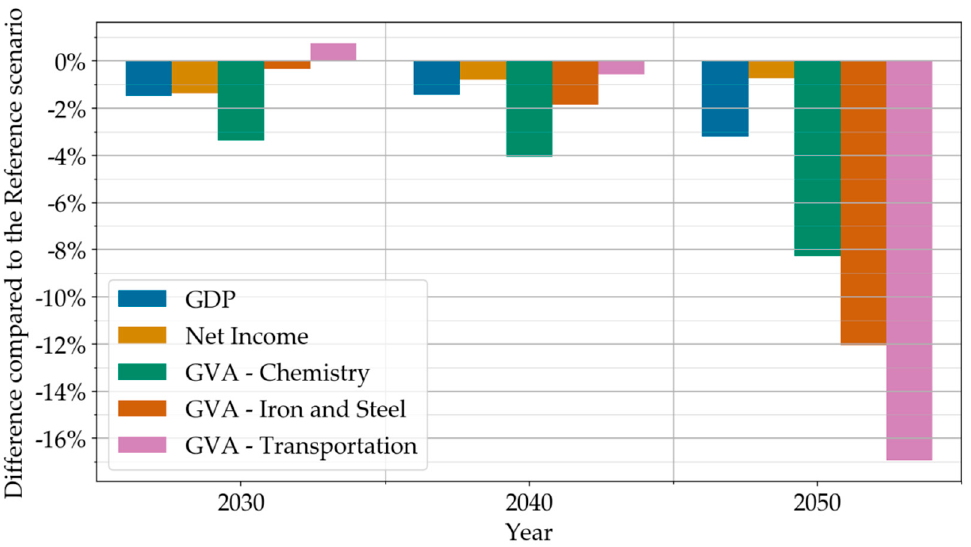
Figure 6. Values of selected economic variables in the EU28 for GHG_DAM compared to the reference scenario.